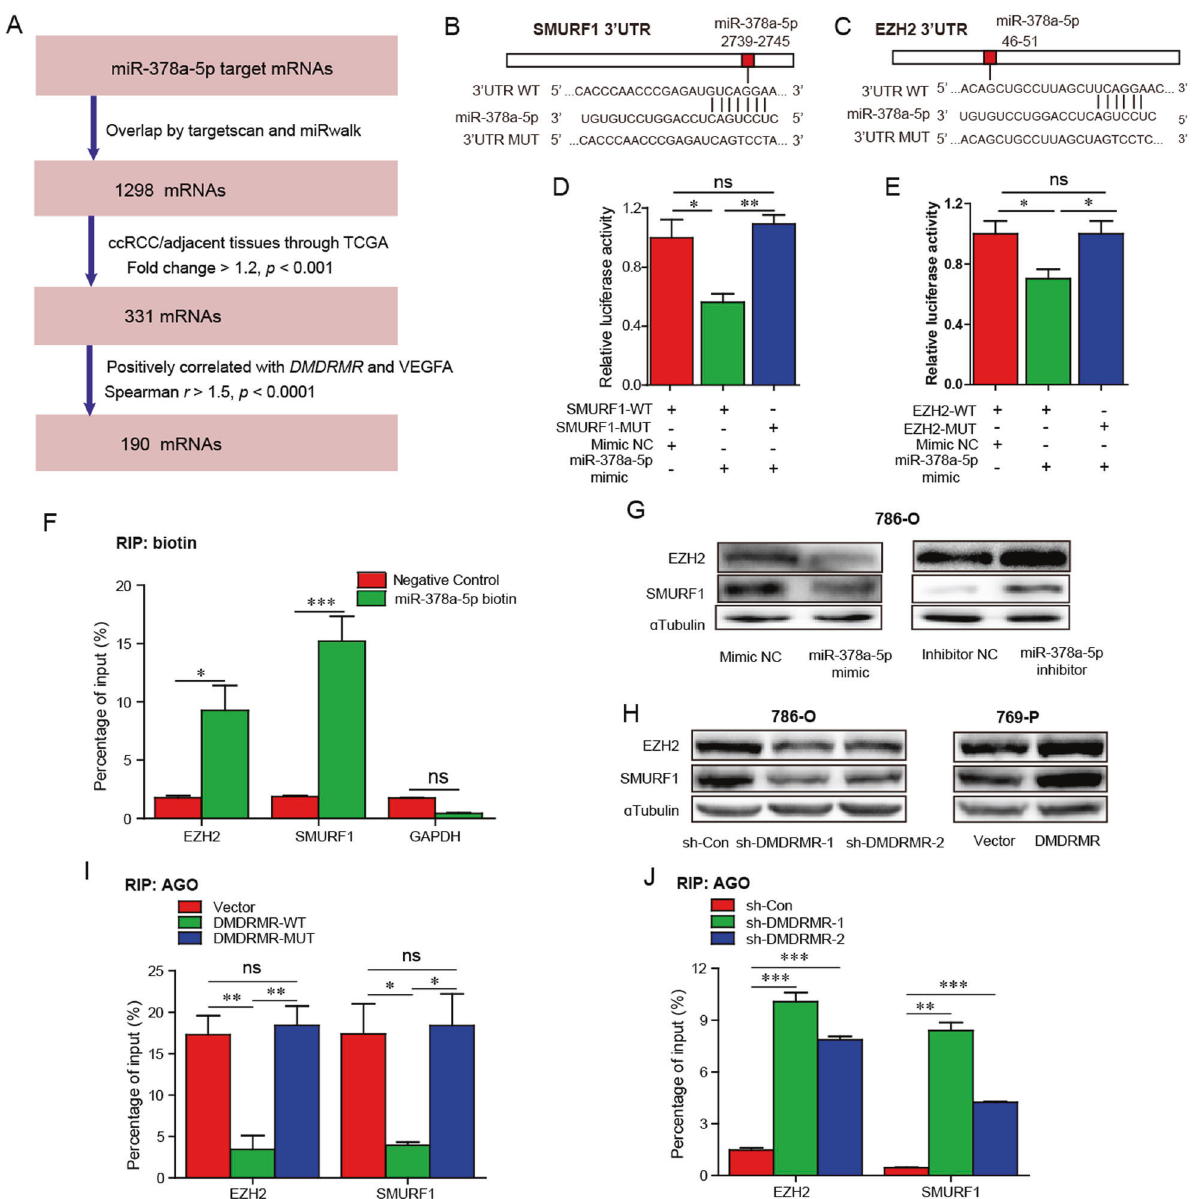
cells (left) and DMDRMR OE 769-P cells (right). I , J Ago2 RIP qRT-PCR assay showing the interaction of EZH2 and SMURF1 with Ago2 in DMDRMR- WT and MUT OE 769-P cells ( I ) and in DMDRMR KD 786-O cells ( J ). The results are presented as mean ± SEM. * p < 0.05, ** p < 0.01, and *** p < 0.001. ns, no signi fi